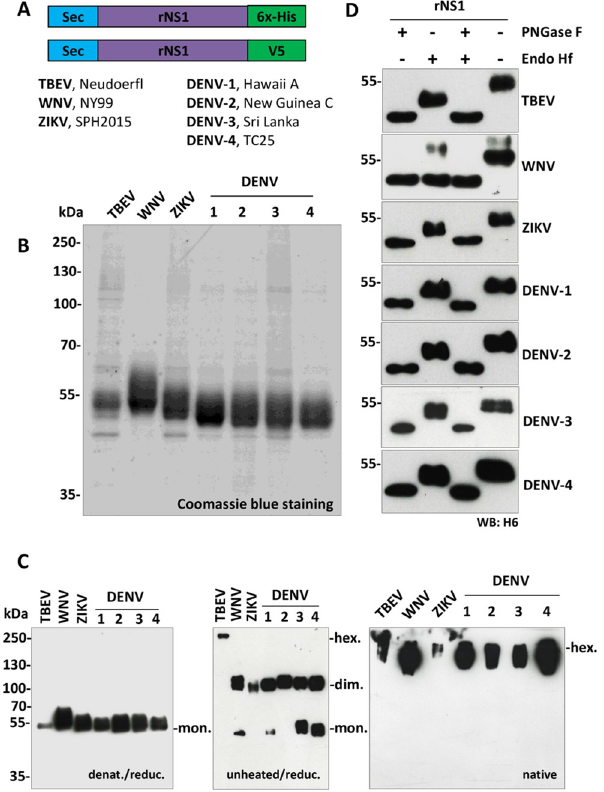
Fig 1. Cloning, expression, and purification of rNS1. A) Schematic representation of expression constructs pcDNA3.1-sec-NS1-6xHis (upper) and pcDNA3.1-sec-NS1-V5 (lower). Sec corresponds to an immunoglobulin leader sequence at the N-term; rNS1, recombinant nonstructural protein 1; 6xHis and V5 are tags cloned at the C-term for protein purification and mice immunization, respectively. Reference strains are also indicated. B) Coomassie blue staining of purified proteins: 2 μ g of purified NS1 proteins were loaded for each virus. C) Western blot analysis of purified rNS1. Left panel, WB of purified rNS1 proteins diluted in reducing Laemmli sample buffer (LB) and denatured by boiling using an anti-6xHis-tag mAb (WB: H6). Middle panel, WB of rNS1 performed in non- denaturing/non-reducing conditions (without heating the proteins and LB without 2- β ME). Right panel, WB of purified rNS1 proteins analyzed by western blot under native conditions (without heating the proteins; without 2- β ME and without SDS in the LB buffer, gel, and running buffer). rNS1 monomers (mon), dimers (dim), and hexamers (hex) are indicated. D) Endoglycosidase analysis of purified rNS1. All rNS1 proteins were treated (+)/or not (-) with PNGase F and/or Endo Hf enzymes for 1.5 h at 37 ˚C. WB analysis was assessed by 10% SDS-PAGE under standard conditions using an anti-6xHis-tag mAb (WB: